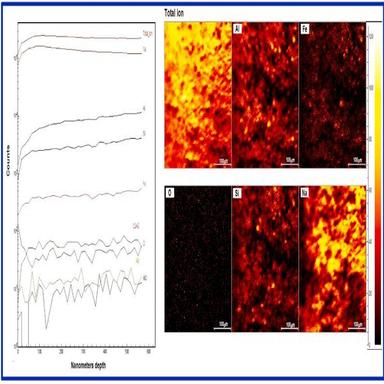
SIMS depth profile for acquisition time 87min and positive ion mapping spectrum of designed geopolymer coating material showing distribution of five secondary ions- Si, Al, Na, Fe, O. Total ion surface mapping is also displayed. (All images at 100 μm scale).